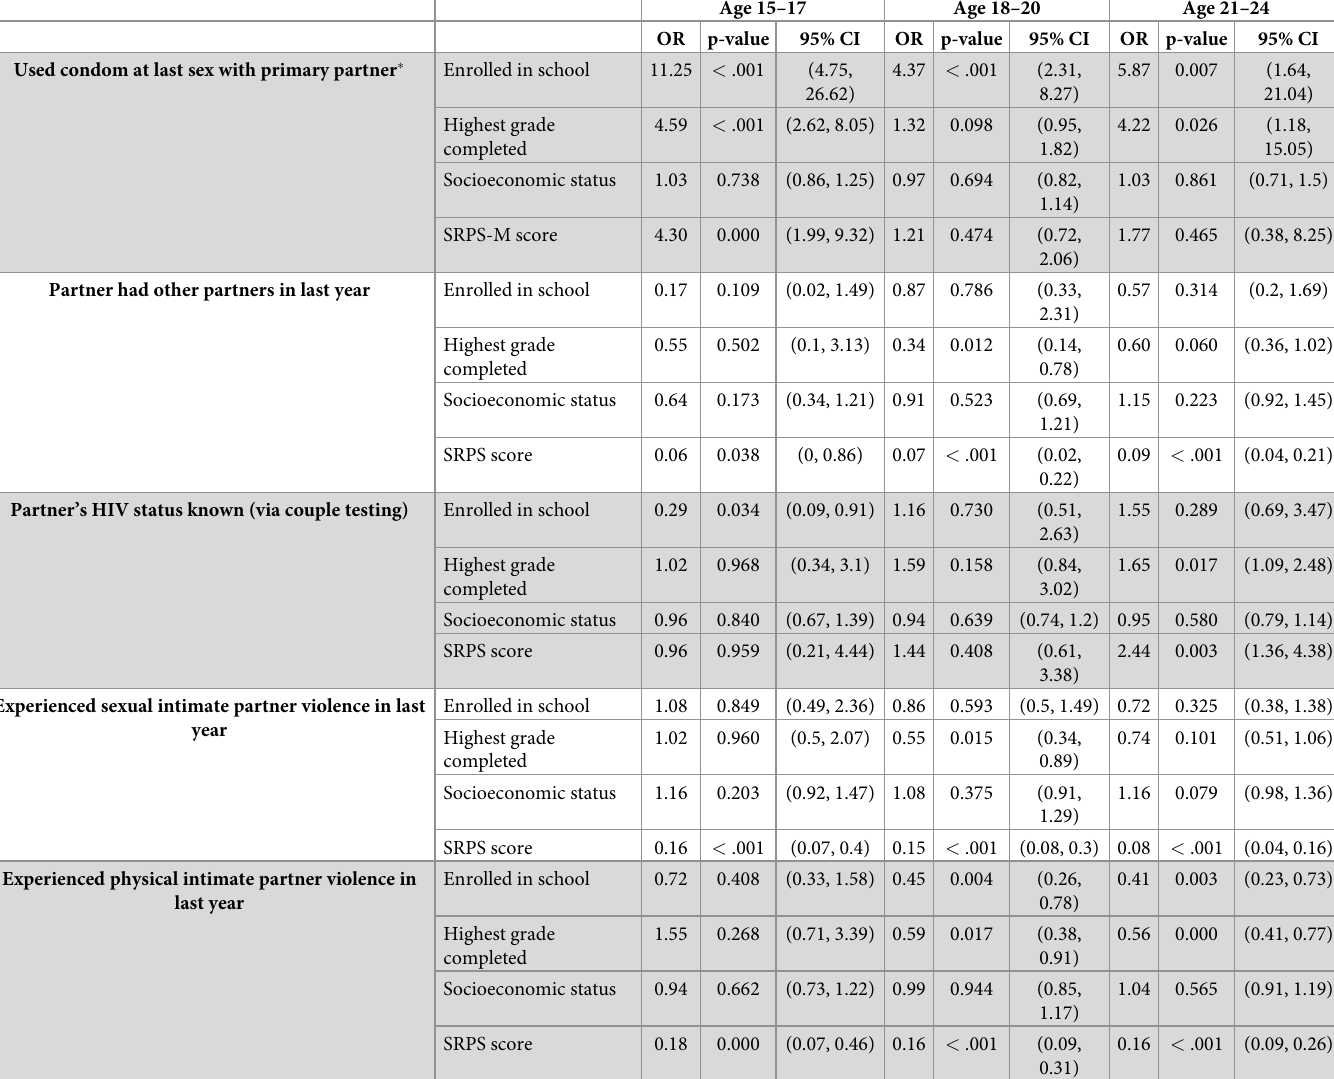
Table 4. Bivariate associations between HIV and partner violence outcomes, and sexual relationship power (SRPS or SRPS-M) and sociodemographic